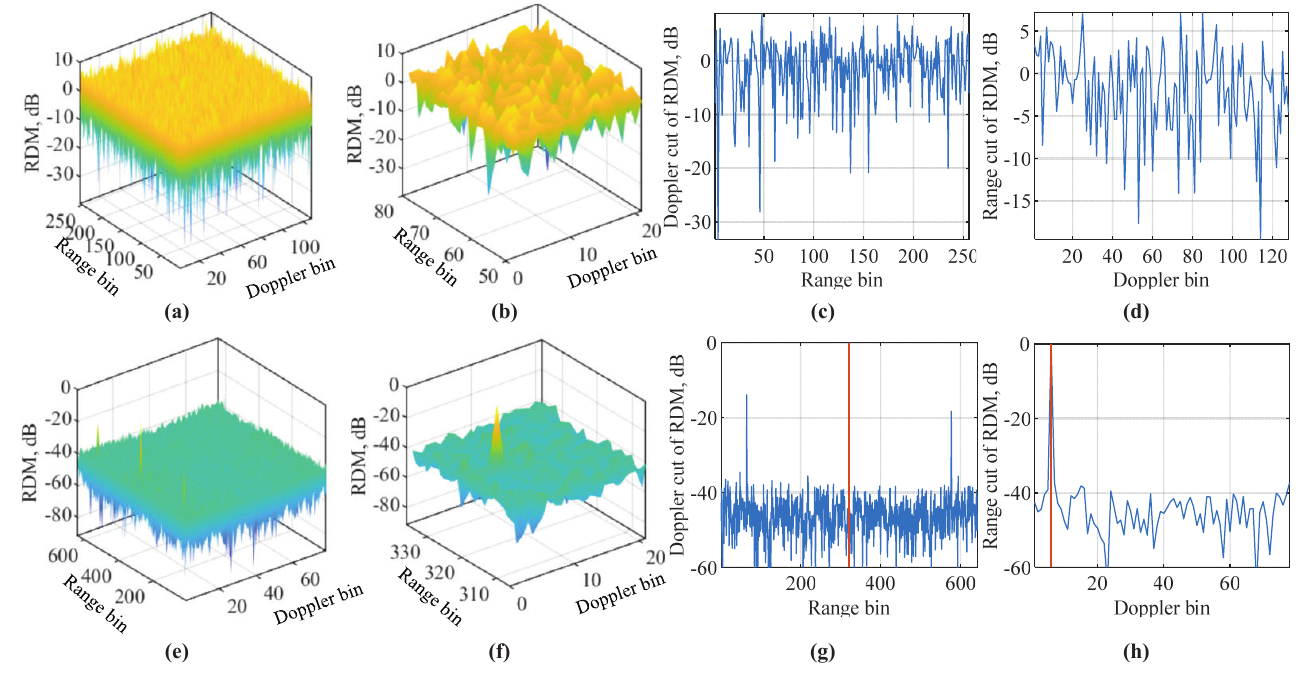
Figure 6. Comparing RDMs of C-COS and the novel sensing framework (NSF) illustrated in Algorithm 1, where simulation parameters are summarized in Table 2, the results in the first row are for C-COS and the results in the second row are for NSF. More specifically, the RDM of C-COS is given in subfigure ( a ), while that of NSF is in subfigure ( e ). Subfigures ( b ) and ( f ) are the zoomed in versions of subfigures ( a , e ), respectively, where the zoom-in centers are the true target range and Doppler bins. Subfigures ( c ) and ( d ) illustrate the range and Doppler cuts of the RDM given in subfigure ( a ); similarly, subfigures ( g ) and ( h ) give those of the RDM in ( e ). Note that COS and NSF are performed with the same communication-transmitted and sensing echo